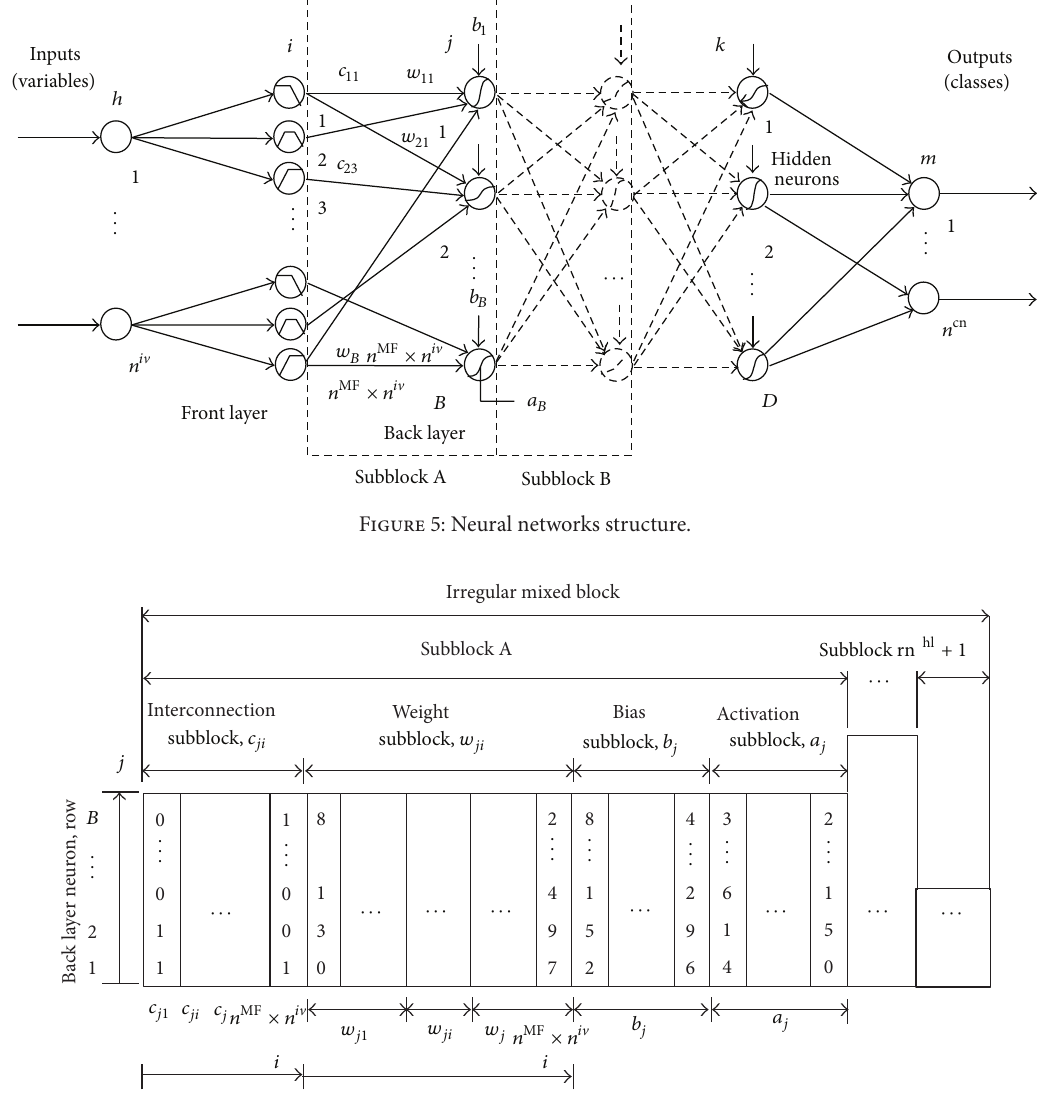
Figure 6: Block Representation Method